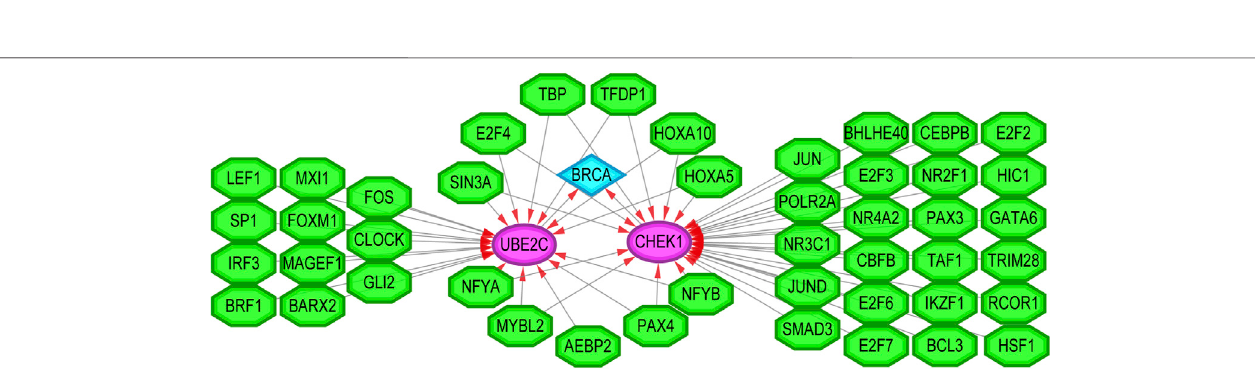
FIGURE10| The transcriptional regulatorynetworkofTFs and thetwohubgenes.TFs: transcriptionfactors. GreenhexagonnodesrepresentedTFs, pinkcircular nodesrepresentedTFsregulatedhubgenes,andlightbluediamondnoderepresentedtheBRCA.Theirinteractionswererepresentedbyarrows.Thenumberofarrows in the networks demonstrated the contribution of one TF to the hub genes. The higher the degree the more central the nodes were within the network.